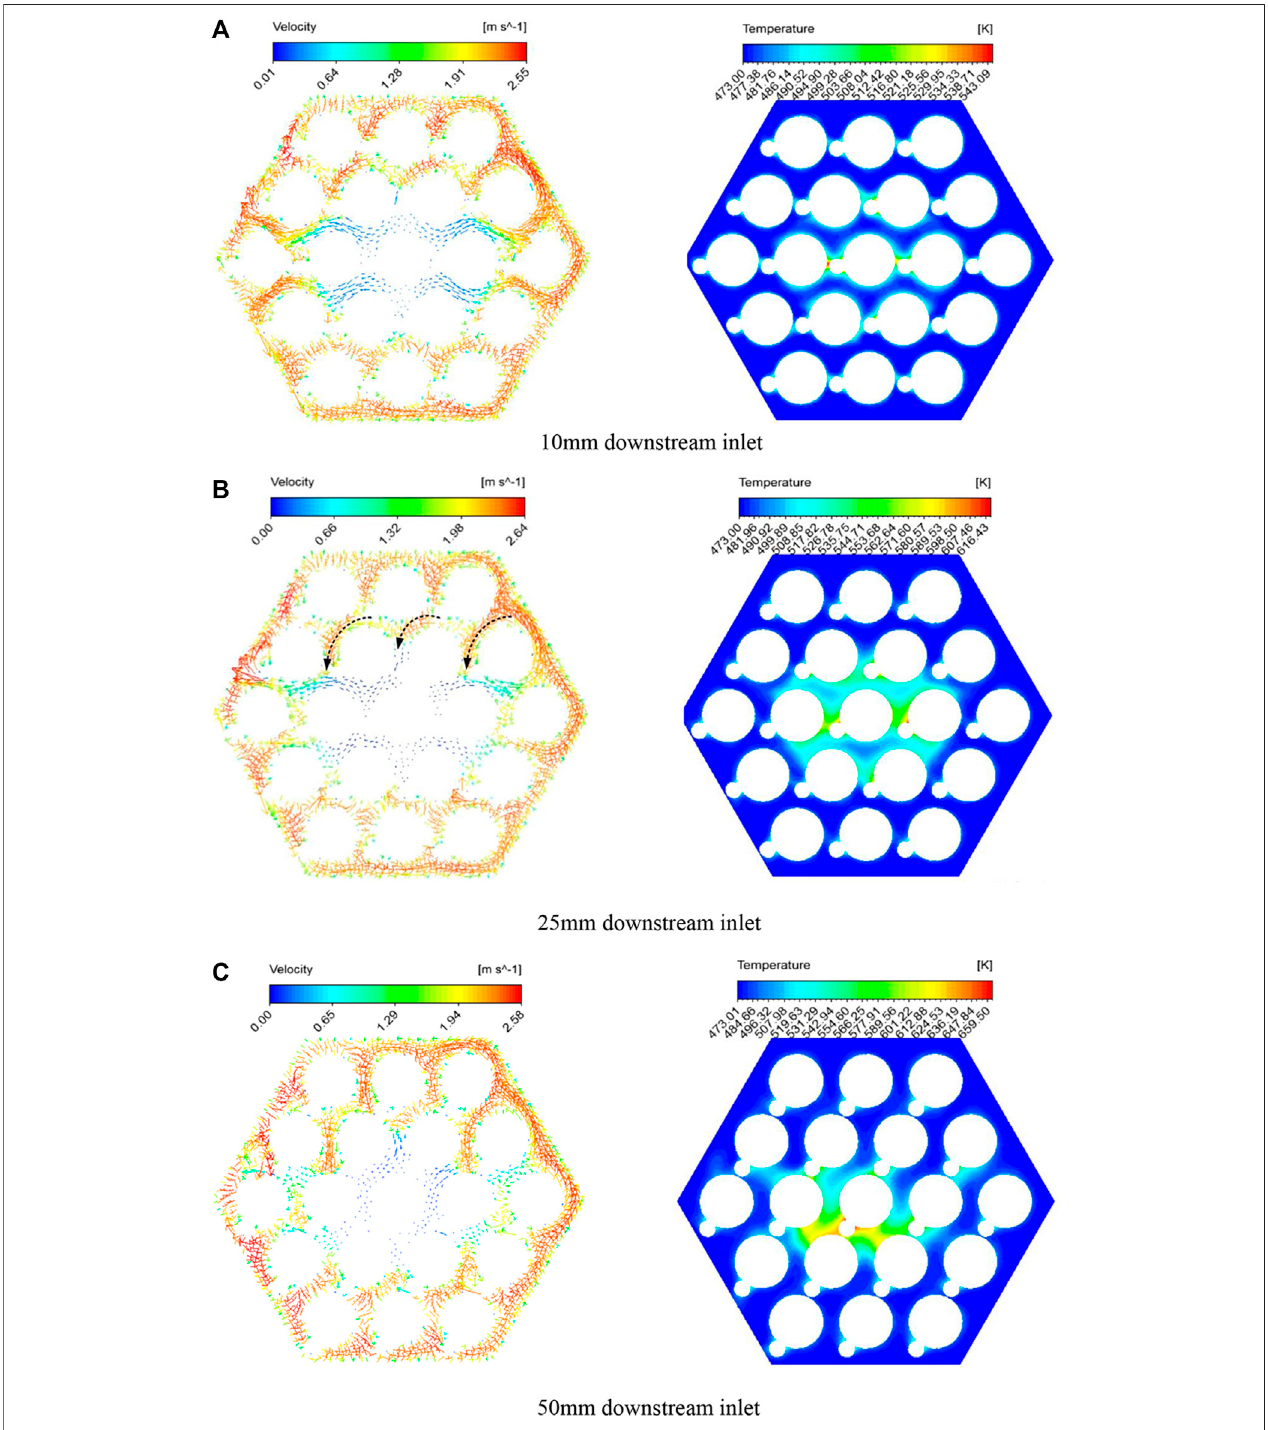
FIGURE12| Thevectorandtemperaturedistributionsincase7. (A) 10 mmdownstreamoftheinlet (B) 25 mmdownstreamoftheinlet. (C) 50 mmdownstreamof the inlet. (D) 25 mm downstream of the blockage. (E) 50 mm downstream of the blockage. (F) 75 mm downstream of the blockage.